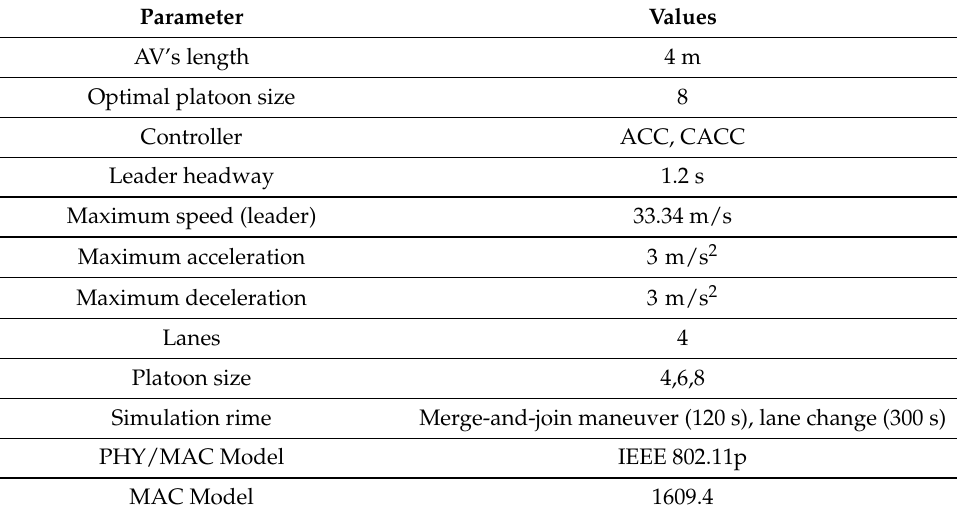
Table 2. Simulation Parameters.